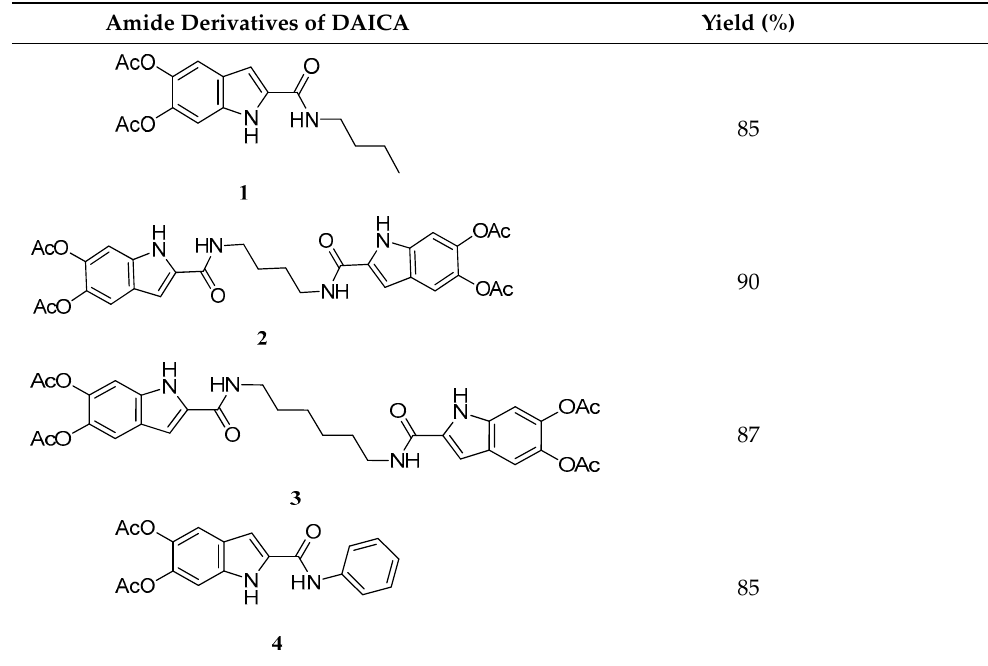
Table 1. Structure and yields of the synthesized DAICA carboxamides.